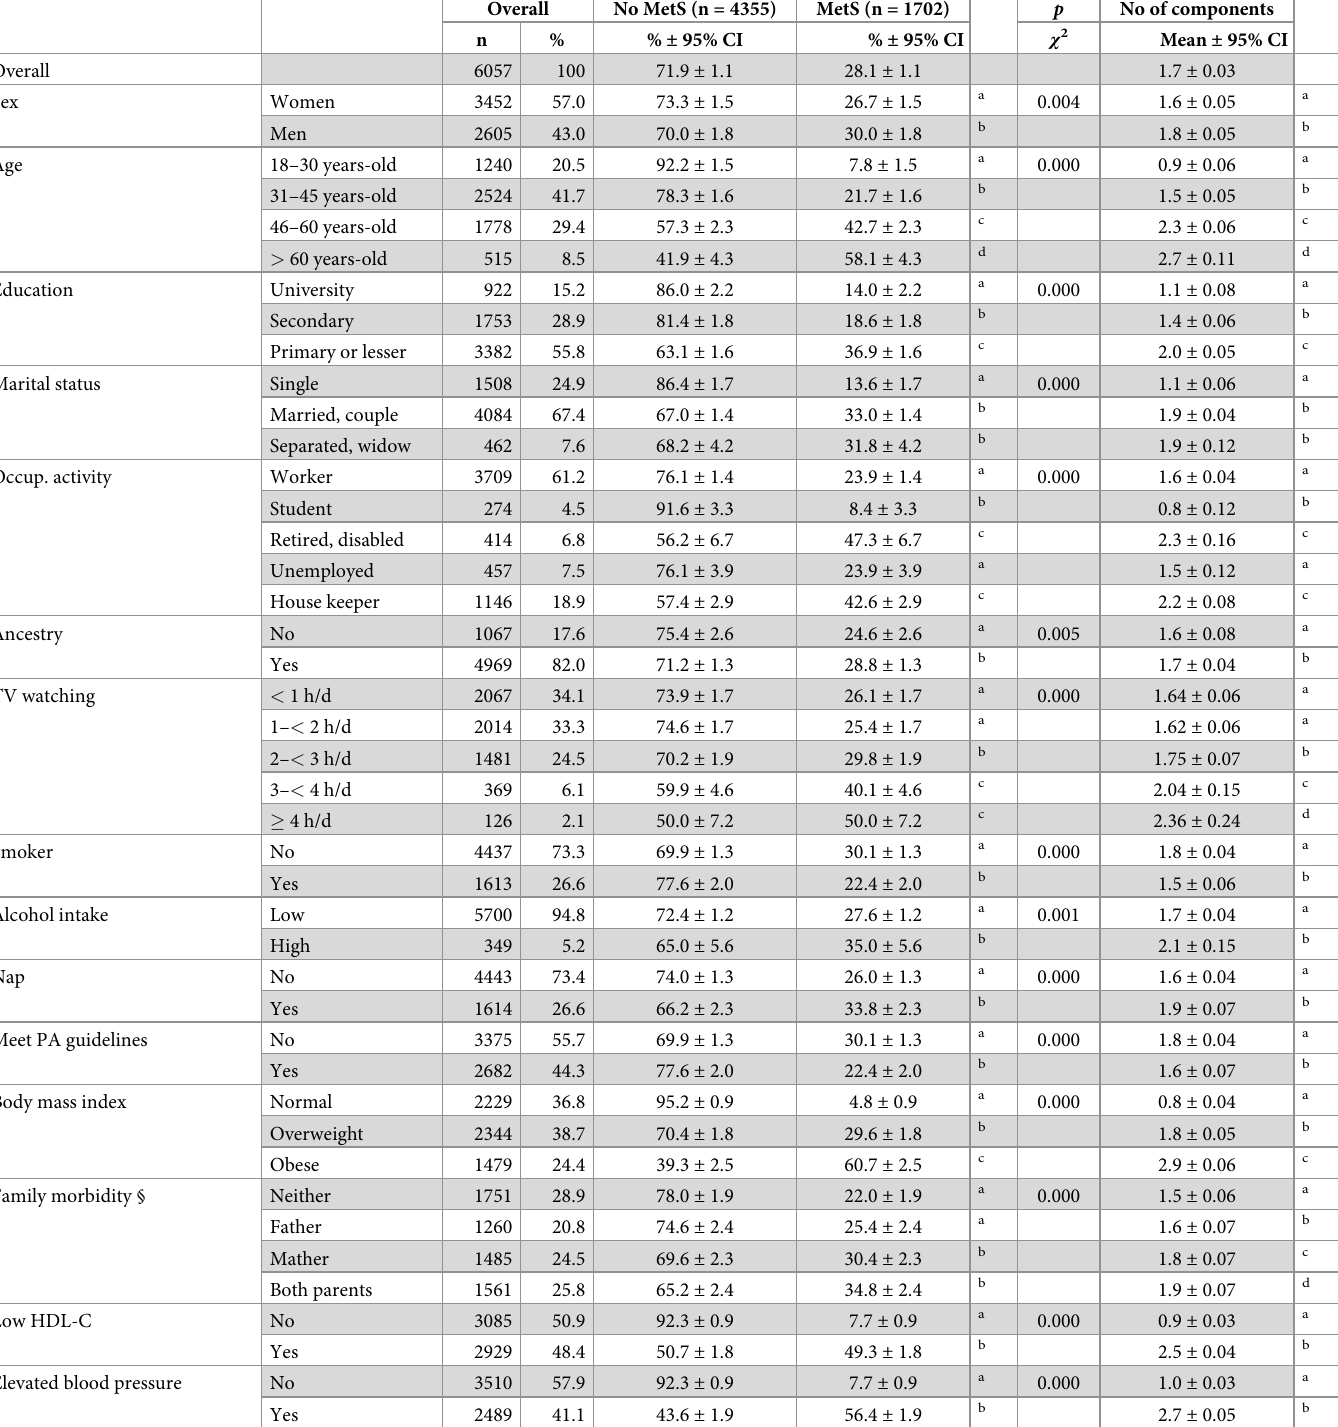
Table 1. Distribution of the participants according to socio-demographic characteristic, lifestyle, metabolic syndrome components, BMI and family history of morbidity.